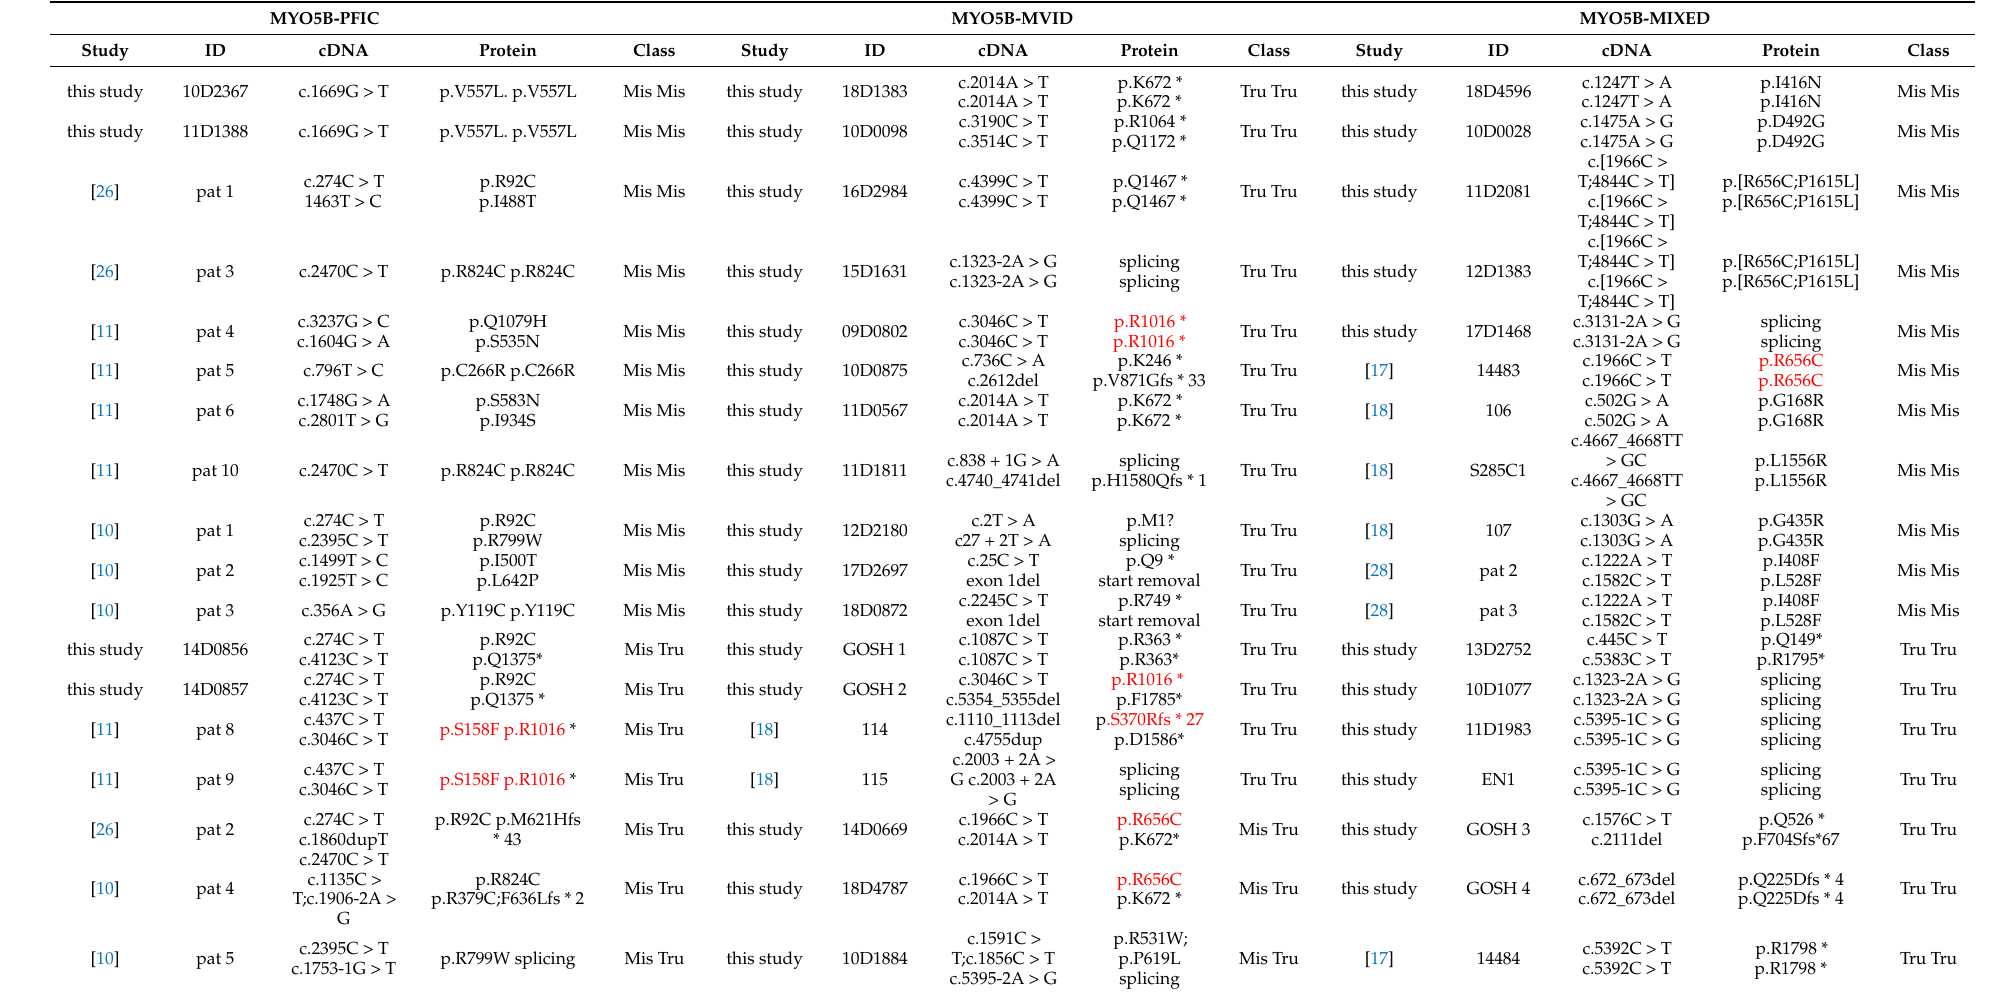
Table 4. MYO5B genotypes ( n = 86) associated with MYO5B-PFIC, MYO5B-MVID,